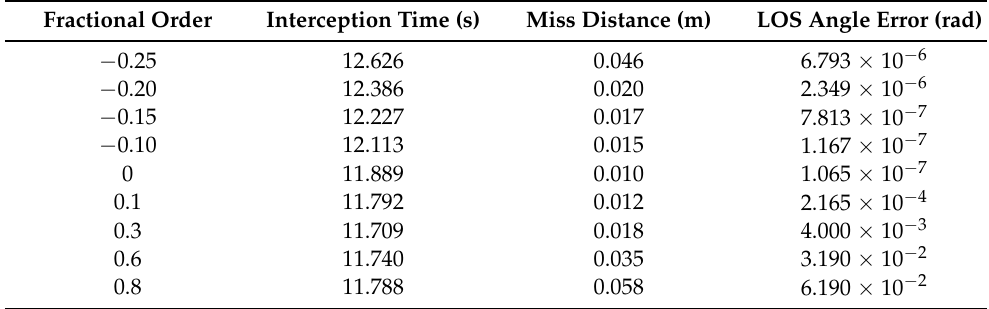
Figure 3. Simulation results with α = − 0.25, − 0.20, − 0.15, − 0.10 in case 1. Table 4. Interception times, miss distances, and LOS angle errors of the proposed guidance laws under different fractional orders in case